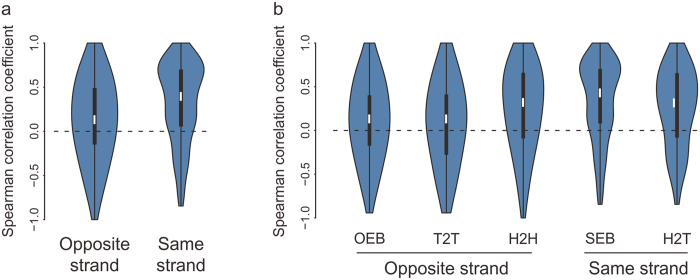
Widespread expression correlation of lncRNA-coding pairs.(a,b) Distribution of Spearman correlation coefficient between lncRNA and its protein-coding overlapping partner by overlapping strand (a) or overlapping configuration (b). Vioplot also displays the full distribution of data, not only the summary statistics.